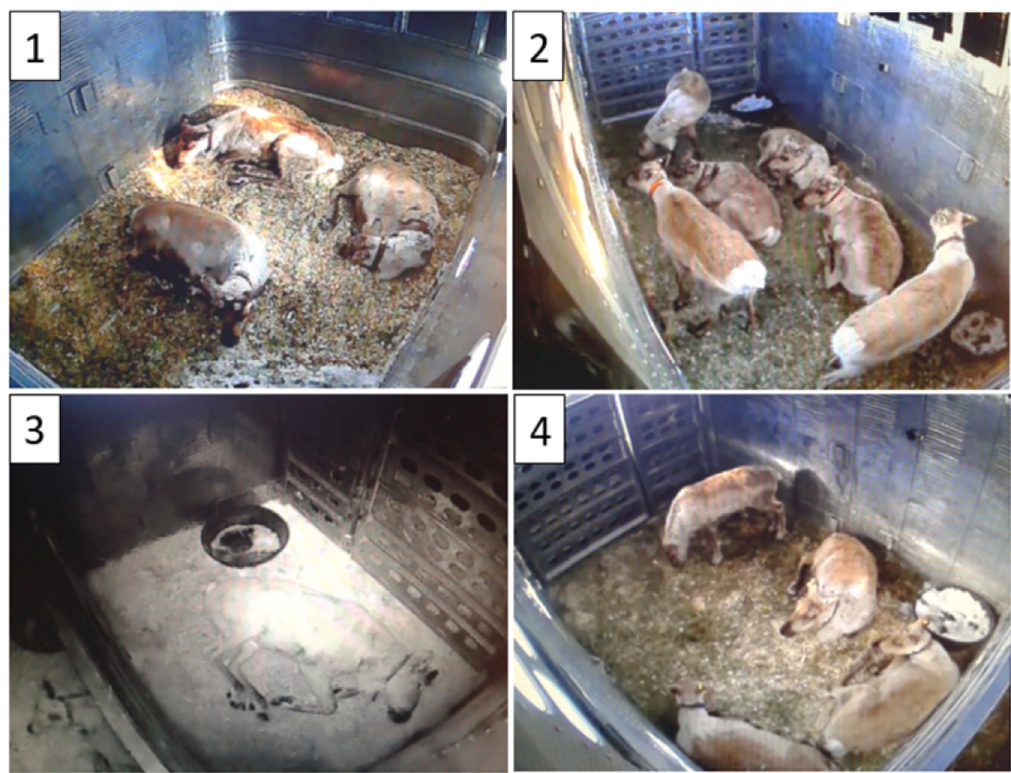
Figure 2. Still images obtained from recorded videos used to monitor caribou within each compartment (1-4) and to retrospectively analyse caribou lying behaviour during long distance transport (<2300km; 28.5 h) from British Columbia to Ontario, Canada, April 2017. Note the small group sizes and low animal density to provide ample room for animals to lie down. Compartment 3 illustrates transport at night when cameras switched to infrared, with the bull caribou resting in lateral recumbency for a portion of the